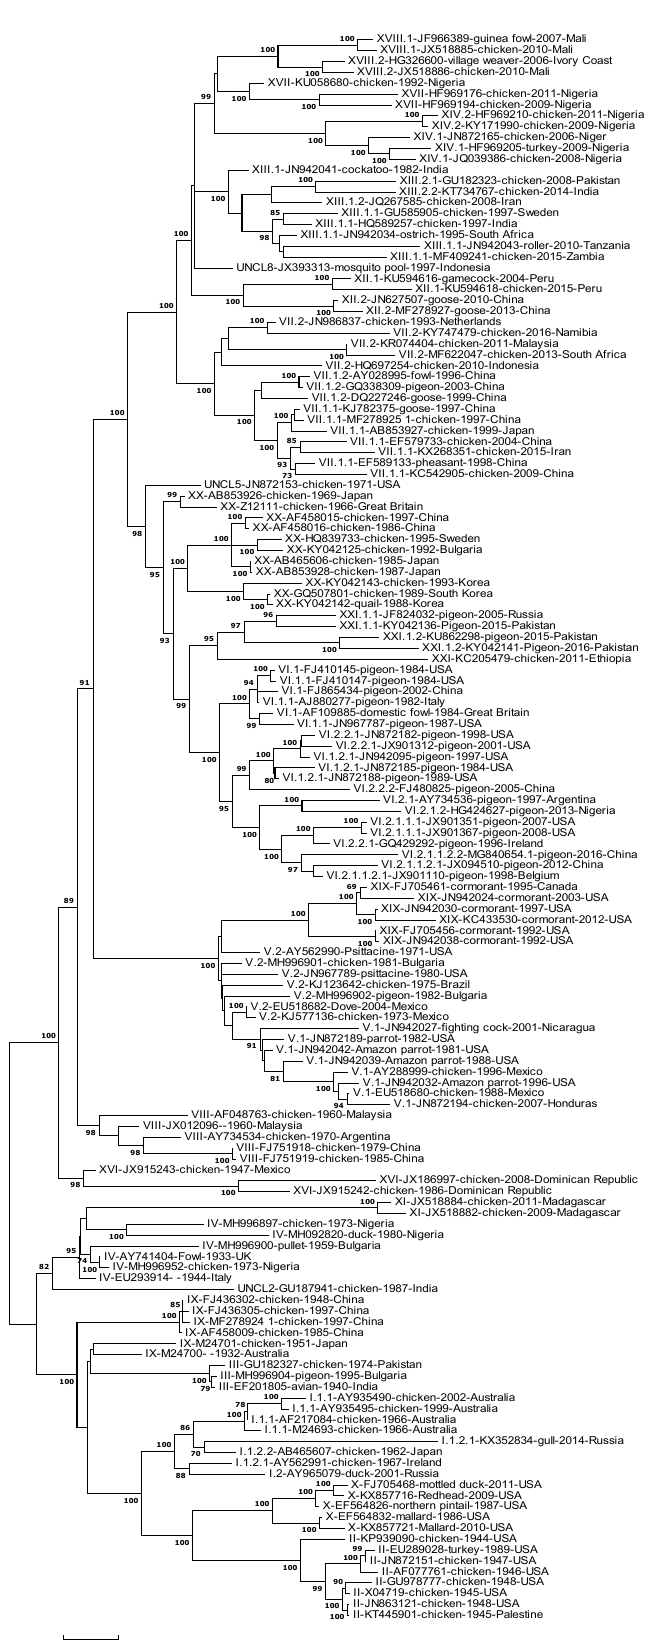
Figure 4. Molecular phylogenetic analysis of NDVs representing historical and current genotypes by the maximum likelihood method. The evolutionary history was inferred by using the maximum-likelihood method based on the general time reversible model. The tree with the highest log likelihood ( −